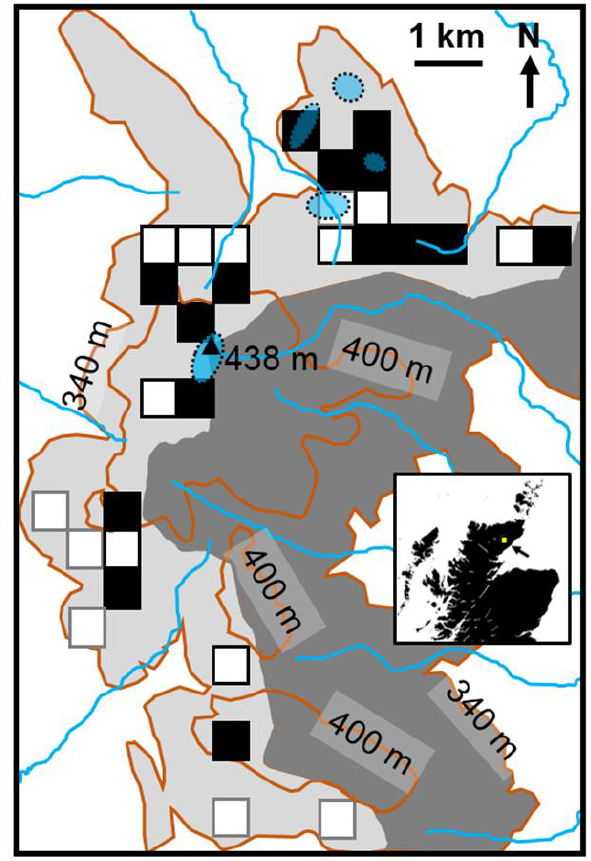
Figure 1. The study area: the Knockfin Heights plateau. The focal area was the part of the plateau above 340 m altitude, including the area which was sampled (light grey) and the area where permission to survey was not given (dark grey). The 340 m and 400 m contours are shown as dark orange lines. Survey squares are indicated in black (more eroded stratum) and white (less eroded stratum); a grey boundary indicates that the square was intended for survey but not completed (less eroded stratum only). The studied pool groups are marked as ellipses (light blue, semi-transparent, with dotted boundaries). The summit of the plateau (438 m) is shown as a small black triangle (location: 58° 17.7' N, 3° 50.1' W). The main streams flowing down from the plateau are shown as light blue lines. An inset map shows the location of the study area (yellow rectangle, arrowed) within northern